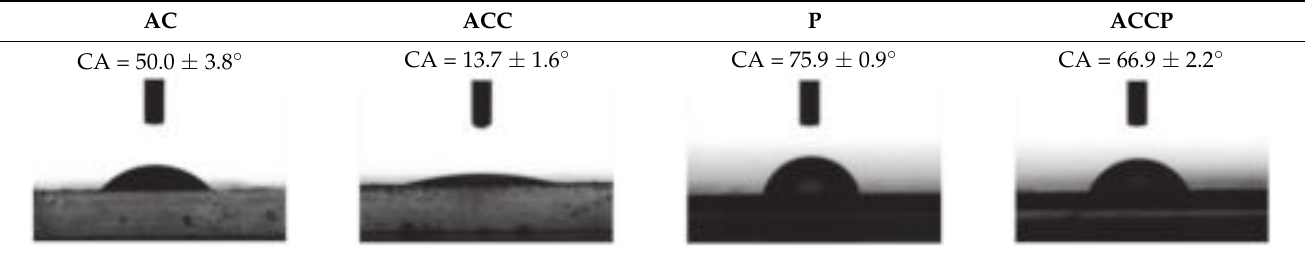
Table 2. Average water contact angle (CA) values with corresponding standard deviations for respective formulations. AC ACC P ACCP CA = 50.0 ± 3.8